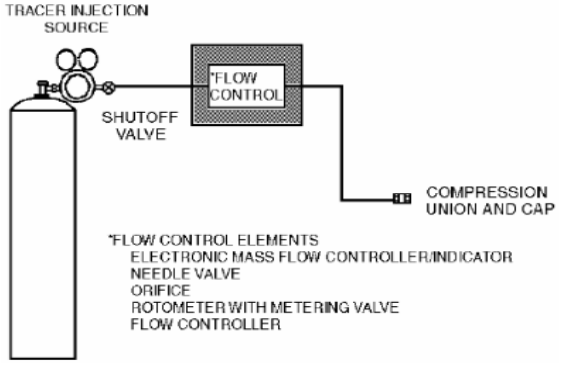
Figure 1. Schematic of the injection manifold.